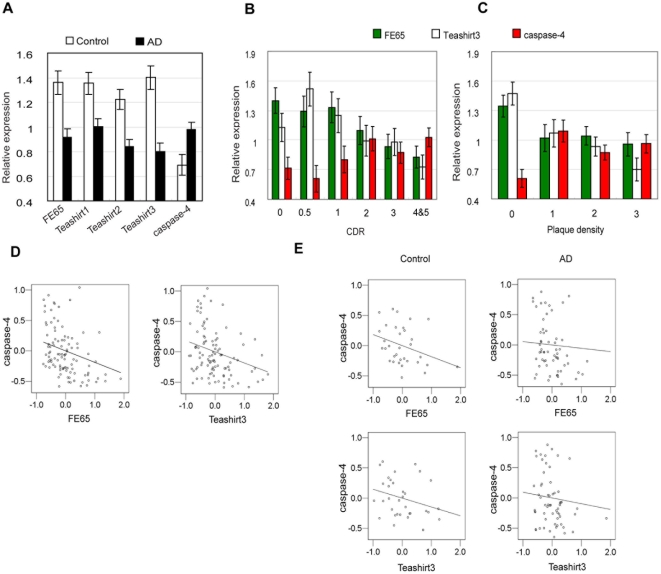
Altered expression of Teashirt and caspase-4 genes in AD.
A, Altered expression of FE65, caspase-4 and Teashirt gene products in AD. Expression of the indicated genes in BA28/36 was assessed by qPCR, comparing expression in controls with that in subjects with probable or definite AD. All comparisons between cases and controls were significant (P< = 0.003) (see text for a full description of statistical analyses). B, Altered expression of FE65, caspase-4 and Teashirt gene products as a function of CDR score. Expression of the indicated genes in BA28/36 was assessed by qPCR, comparing expression in individuals with differing degrees of cognitive impairment as assessed by CDR. For simplicity, results for Teashirt1 and Teashirt2, which paralleled the results for Teashirt3 and are summarized in the text, have been omitted from the figure. C, Altered gene expression of FE65, caspases-4 and Teashirt gene products as a function of plaque density. Expression of the indicated genes in BA28/36 was assessed by qPCR, comparing expression in individuals with differing degrees of neocortical neuritic plaque density. For simplicity, results for Teashirt1 and Teashirt2, which paralleled the results for Teashirt3 and are summarized in the text, have been omitted from the figure. D, Residuals from linear regressions of caspase-4, FE65, Teashirt1, Teashirt2, and Teashirt3 on APOE4, sex, PMI, and pH were calculated and the associations of residuals between caspase-4 and FE65 or Teashirt genes were plotted, because Pearson correlations of the residuals are equal to partial correlations of the original values. Note that to better visually represent the data, three data points falling outside the graphed area (at positions 1.20, 2.44 and 1.88, −0.46 in left panel and 0.47, 2.44 in right panel), were omitted from the figure but included in the analyses. E, To determine whether the significant correlations in C were driven by disease the analyses were re-done in controls (left panels) and in individuals with probable or definite AD (right panels). Note again that to better visually represent the data, data points (at positions 1.89, −0.35 in the upper left panel, 1.30, 2.15 in the upper right panel, as well as 0.74, 2.15 and 1.86, −0.34) in lower right panel, were omitted from the figures but included in the analyses.